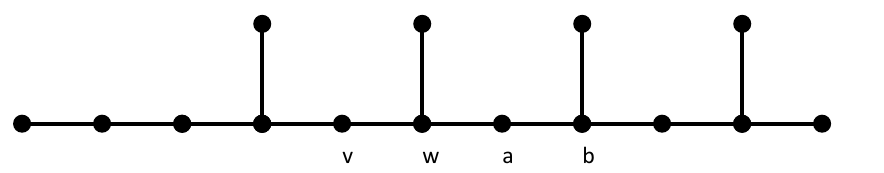
Figure 14: The caterpillar 𝐶 (1 , 0 , 1 , 0 , 1 , 0 , 1 , 0 , 2) of even diameter; p ( 𝑣𝑤 ) = p ( 𝑎𝑏 ) = (1 , 3 , 5 , 8 , 8 , 10 , 7 , 7 , 3 , 2) and 𝑒𝑐𝑐 ( 𝑣𝑤 ) ∕ = 𝑒𝑐𝑐 ( 𝑎𝑏 ).